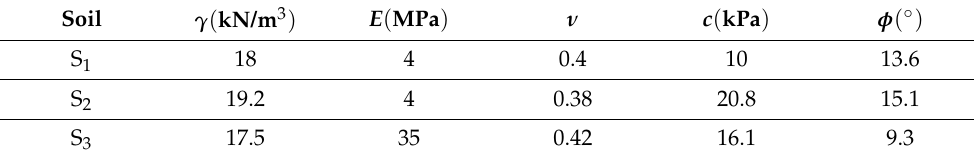
Table 1. Parameters for